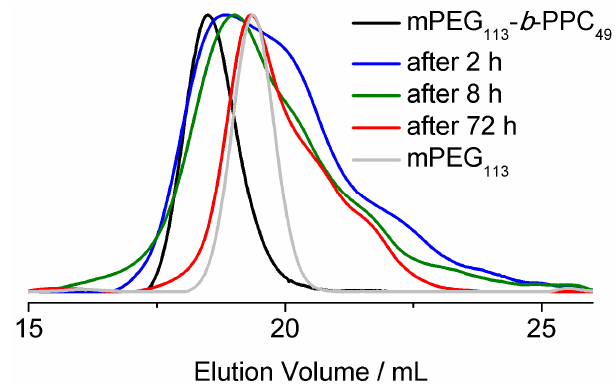
Figure 3. SEC results of the degradation study of mPEG 113 - b -PPC 49 (Table 1, sample 3) in conc. hydrogen chloride in comparison with the mPEG 113 initiator using DMF as eluent and PEG calibration.